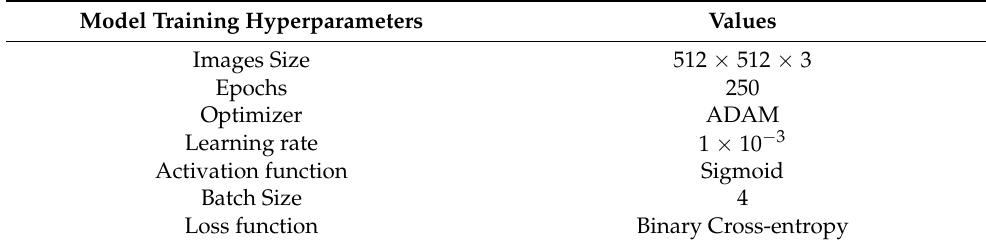
Table 2. The used hyperparameters for the model